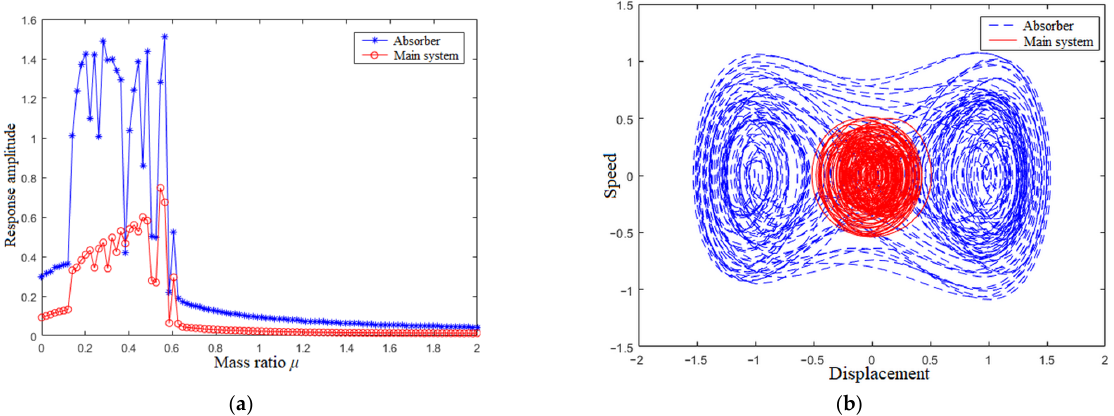
Figure 13. Response amplitude and phase diagram of two vibrators in the case of off-resonance ω = 1.6. ( a ) Response amplitude; ( b ) Phase diagram ( µ =